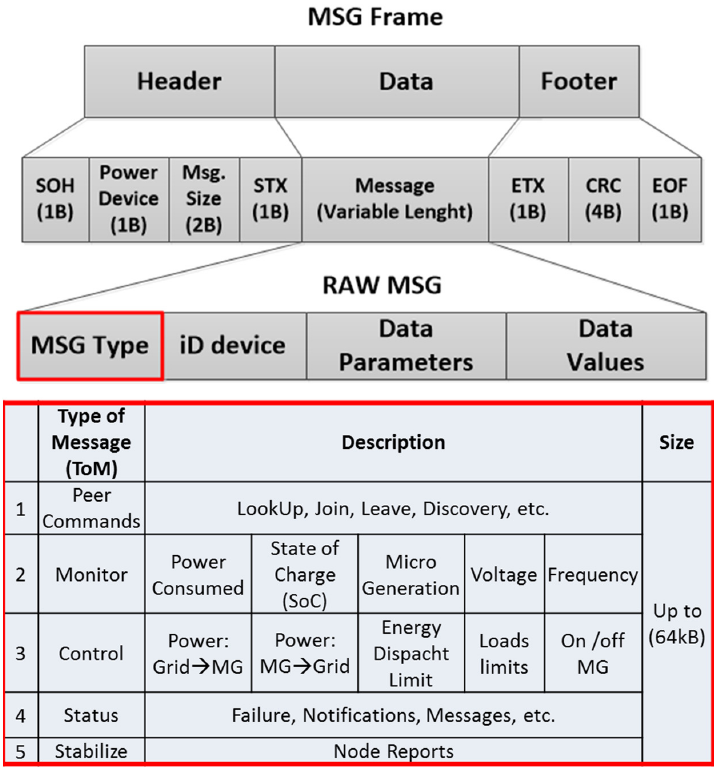
Figure 7. Developed Packet Frame Structure.